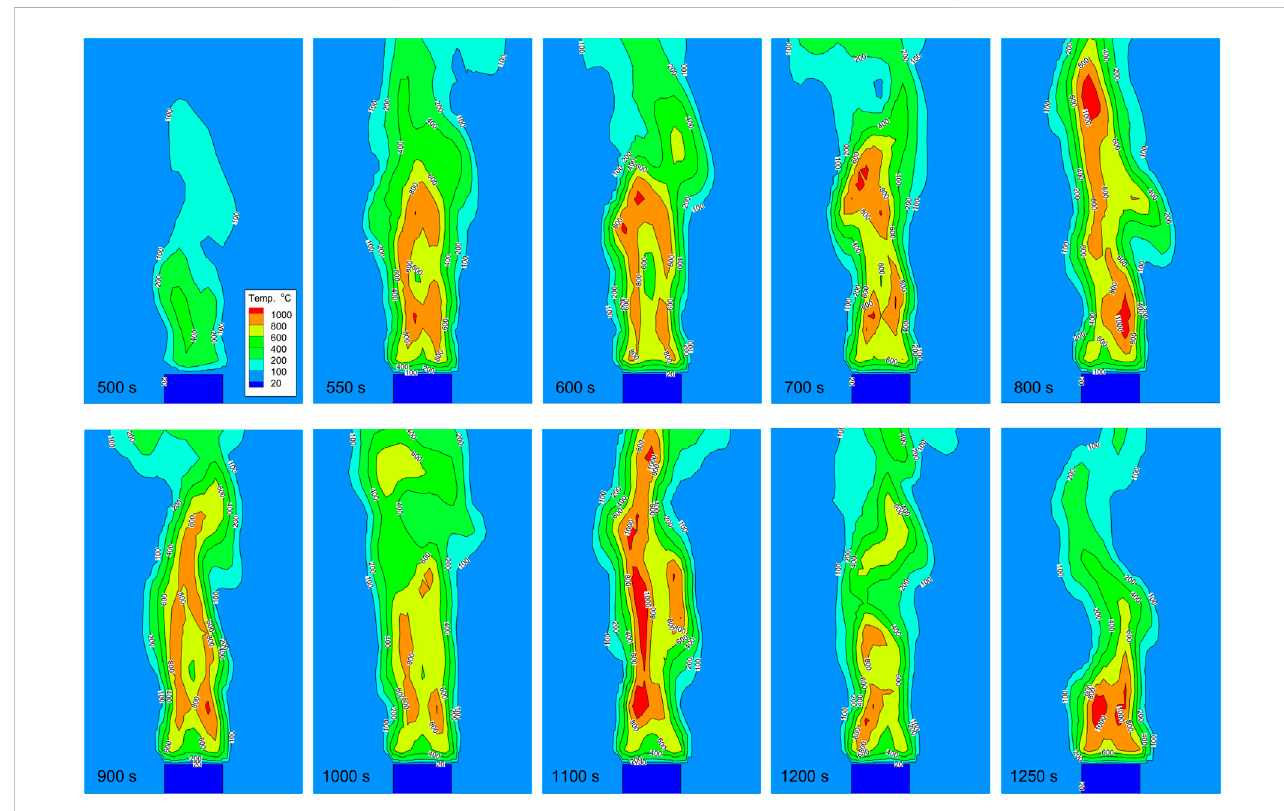
FIGURE 8 Temperature contour of fl ame central section of test No. 4 at water mist fl ow rate 0.75 L/(min · m 2 ) under heat fl ux 50 kW/m 2